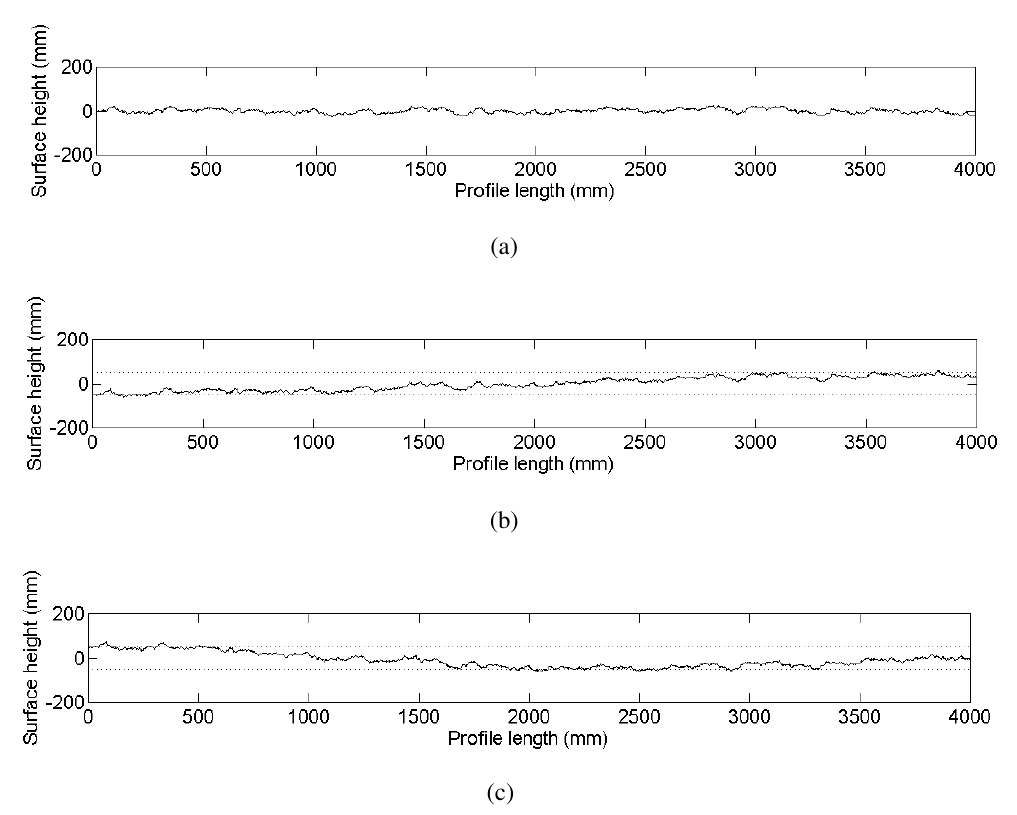
Figure 13. (a) Original simulated 4-m roughness profile with ( s , l ) = (1 cm,5 cm) and a horizontal spacing of 1 mm, added to (b) a linear trend with slope of 0.025 m/m, and (c) a cosine trend with a wavelength of 5 m and an amplitude of 5